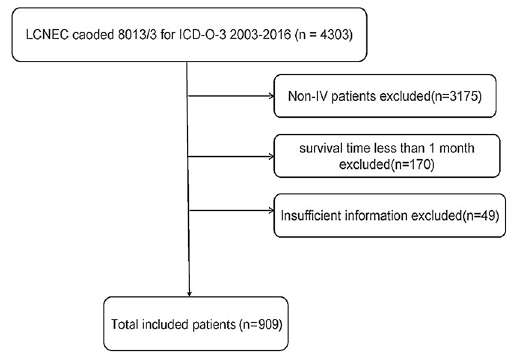
Figure 5. Flowchart of patient